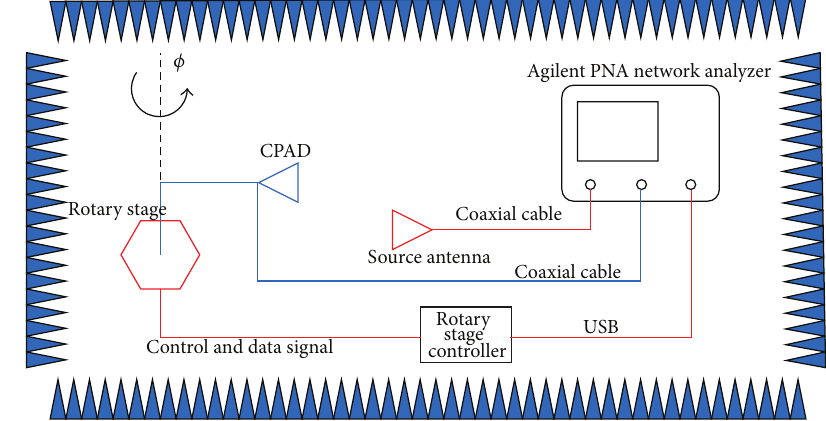
Figure 6: Block diagram of H-H, H-V, V-V, or V-H pattern measurements.